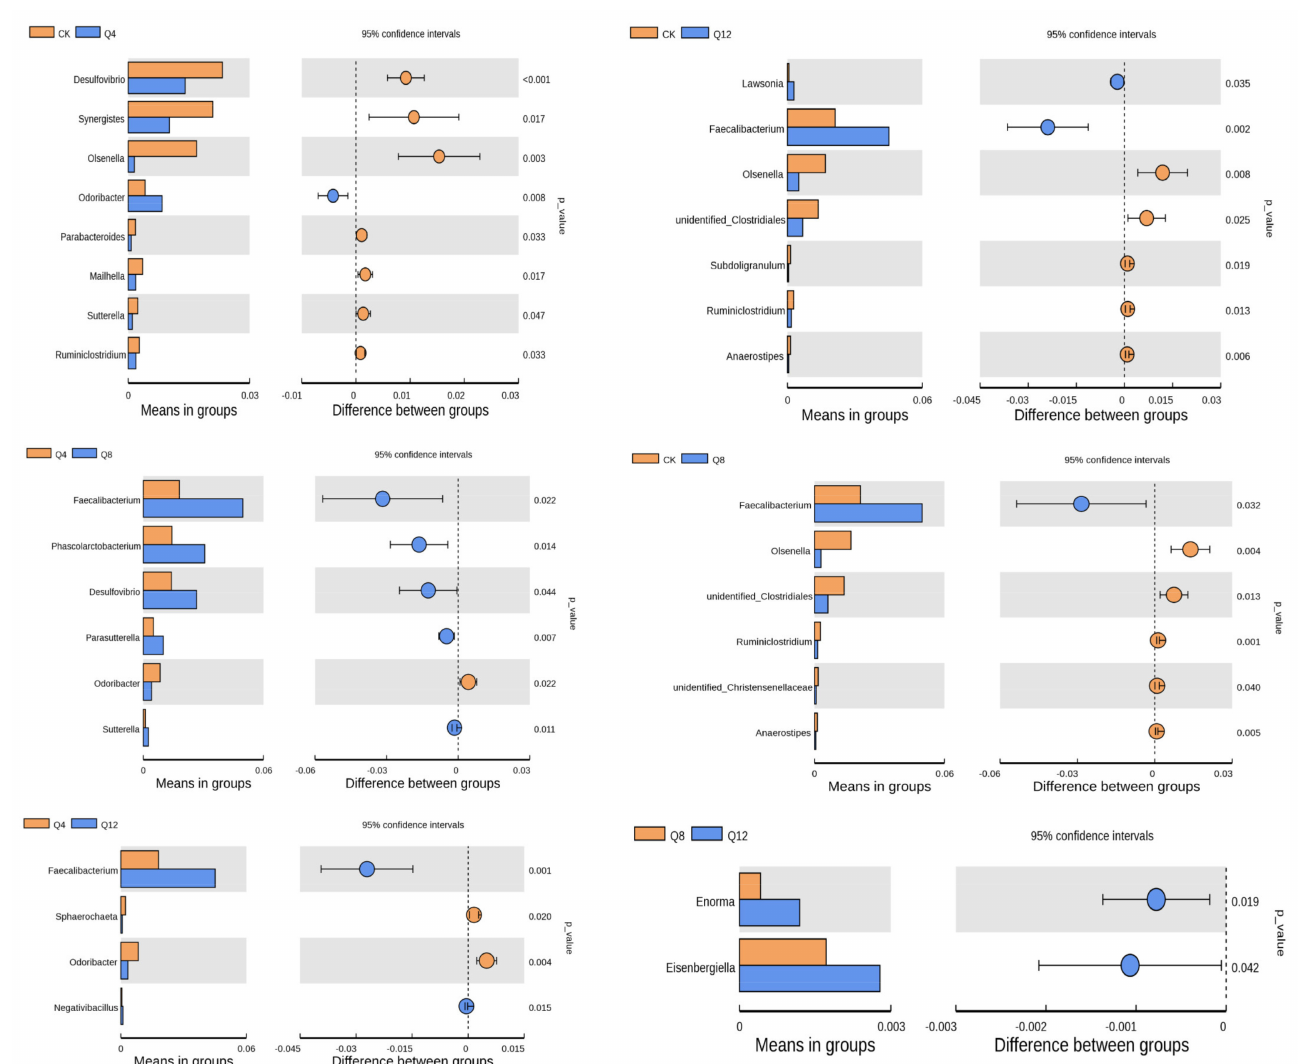
Figure 4. Analysis of species differences between genus level T -test